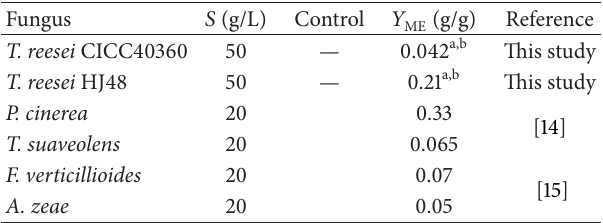
Table 2: Ethanol production by fungi grown on glucose under aerobic